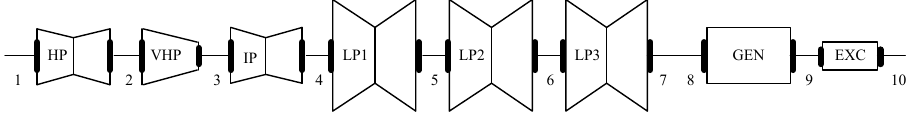
Fig. 1. Schematic diagram of shaft